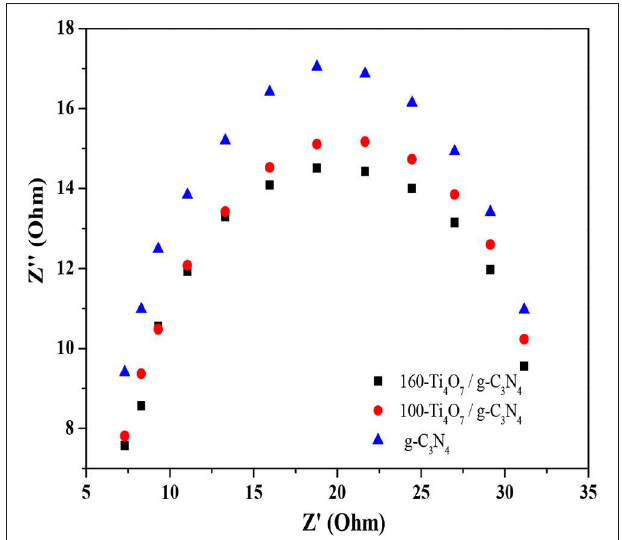
FIGURE 6 | EIS Nyquist plots of the g-C 3 N 4 , 100-Ti 4 O 7 /g-C 3 N 4 , and 160-Ti 4 O 7 /g-C 3 N 4 photocatalysts under visible light irradiation.